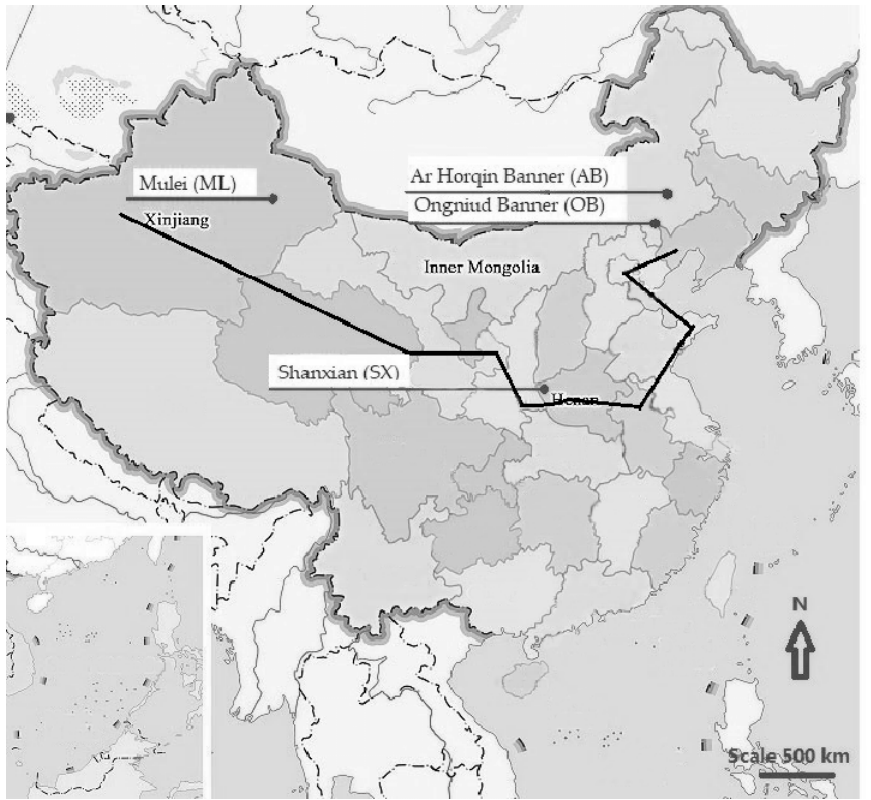
Figure 1. Map of China showing locations of four sampled X. sorbifolium populations. The line represents the limit of X. sorbifolium distribution. Table 1. Geographical location and climatic factors of four X. sorbifolium provenances.